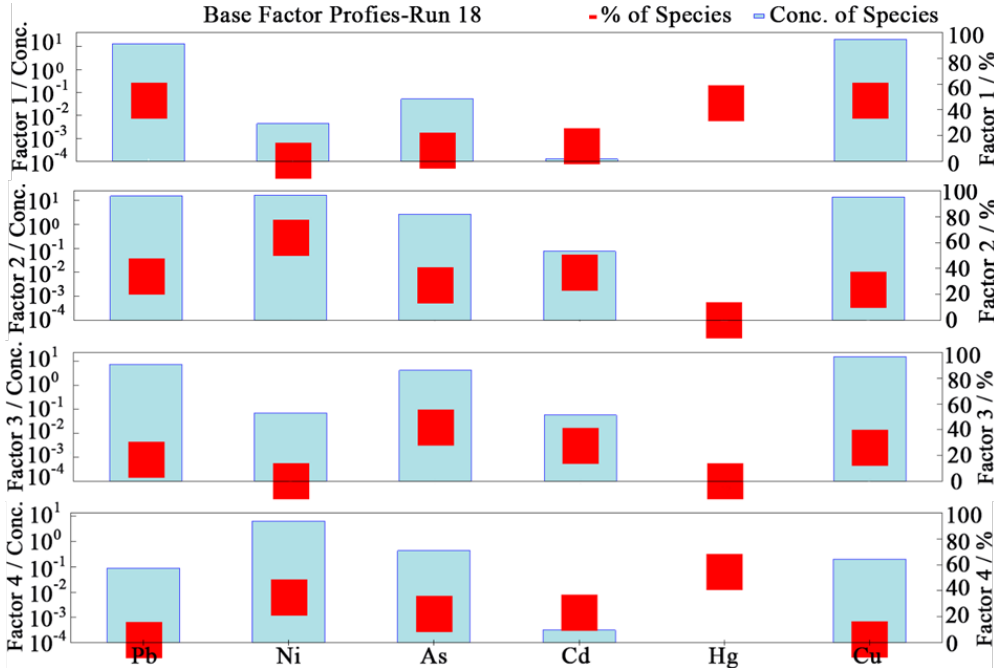
Figure 8. Source composition and source contribution rate of heavy metals based on positive matrix factorization.